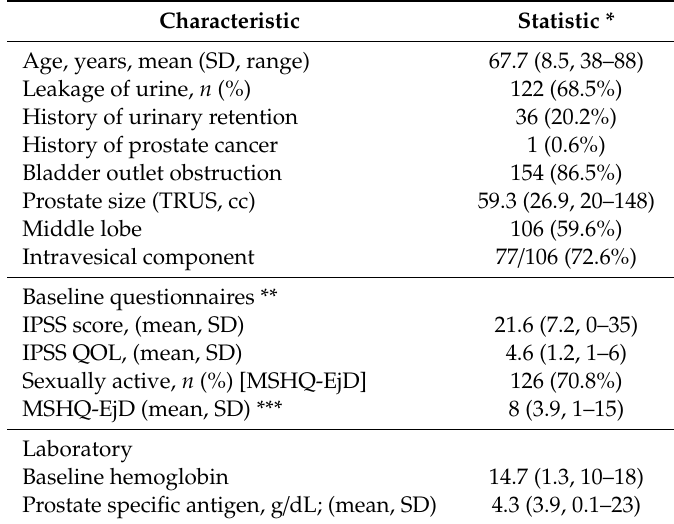
Table 1. Baseline characteristics ( n =